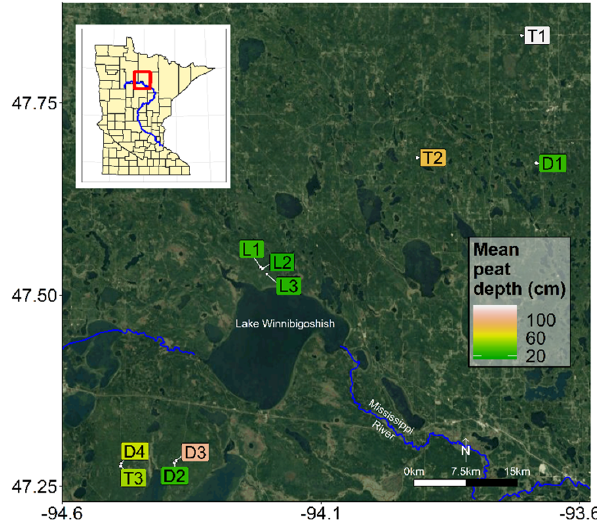
Figure 2. Map of black ash wetland sites. Sites are colored by their mean organic horizon depth. Imagery provided by © Google Maps